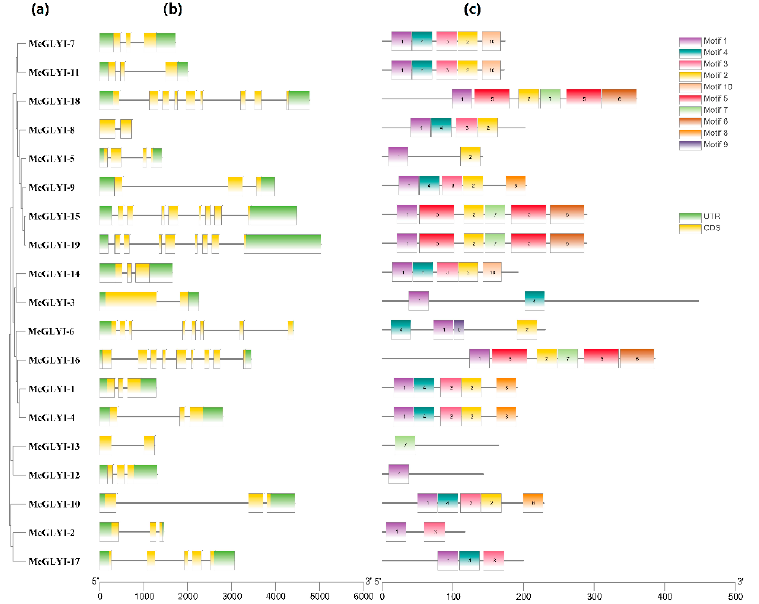
Figure 3. Analysis of gene structure and motifs according to the phylogenetic relationship. ( a ) Phy- logenetic tree conducted based on the full-length sequences of cassava’s 19 MeGLYI proteins. ( b ) Exon–intron structure of cassava’s 19 MeGLYI genes. ( c ) The motif composition of cassava’s 19 MeGLYI